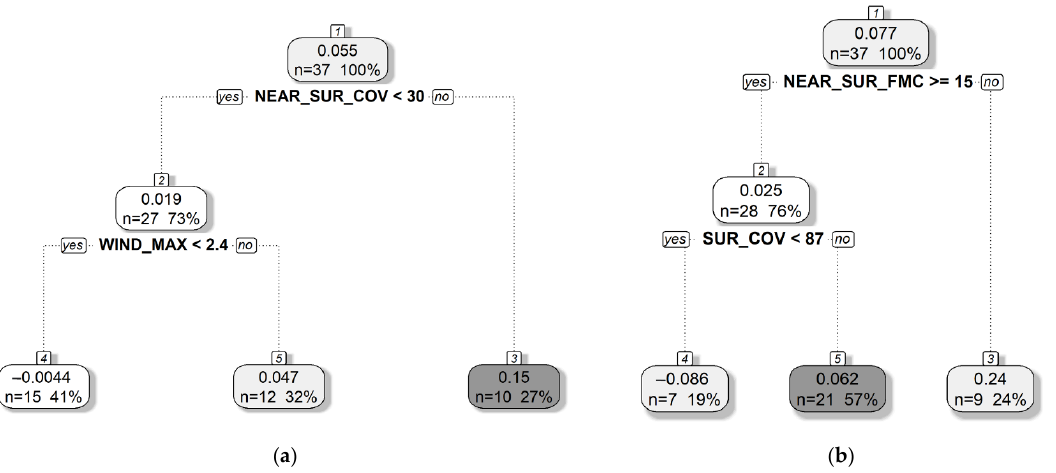
Figure A2. Regression trees for the difference between the field and laboratory result: ( a ) proportion of successful ignitions (R 2 = 0.16); ( b ) proportion of sustained ignitions (R 2 = 0.38).